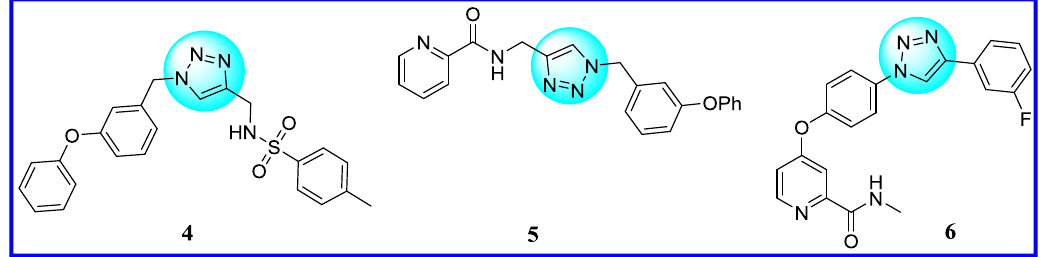
Figure 2 . 1,2,3-Triazole derivatives as novel antitumor agents.